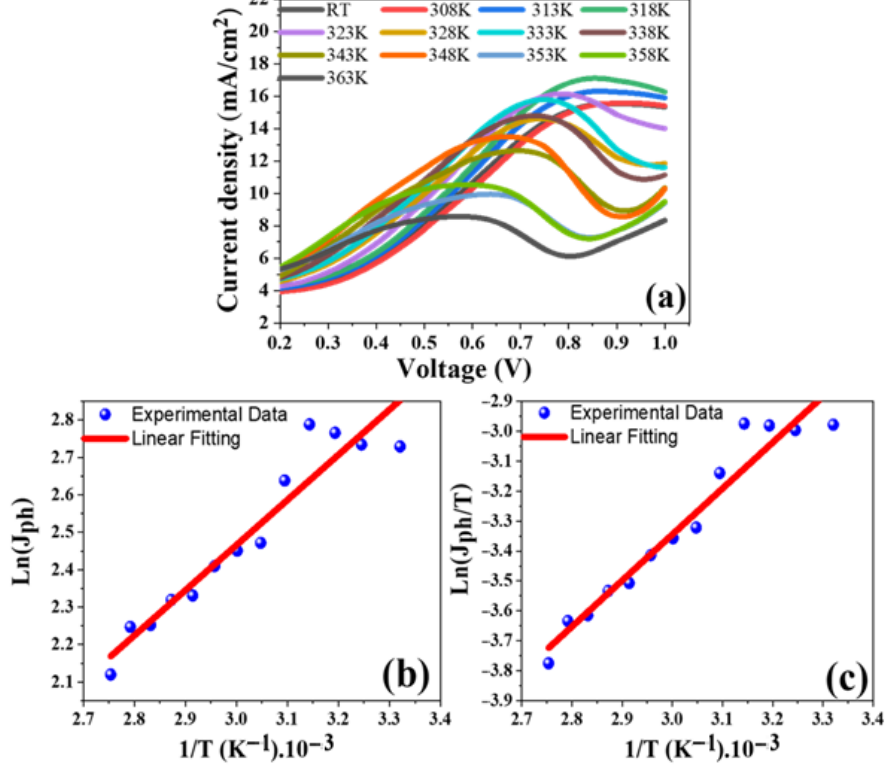
Figure 7. Effect of temperature for the 2.5 % Co, 673 K; ( a ) the change of J ph ‐ voltage curves at distinctive temperatures, ( b ) ln(J ph ) vs. (T − 1 ), and ( c ) Ln(J ph .T − 1 ) vs. (T − 1 ).